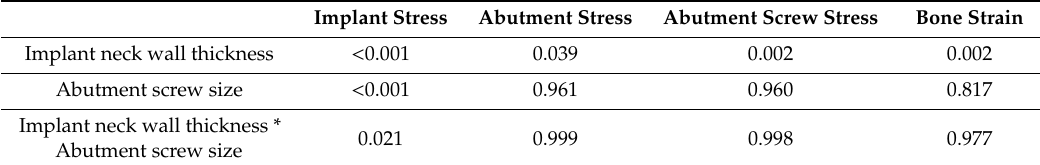
Table 4. The ANOVA test p -values ( p < 0.05 shows significance).